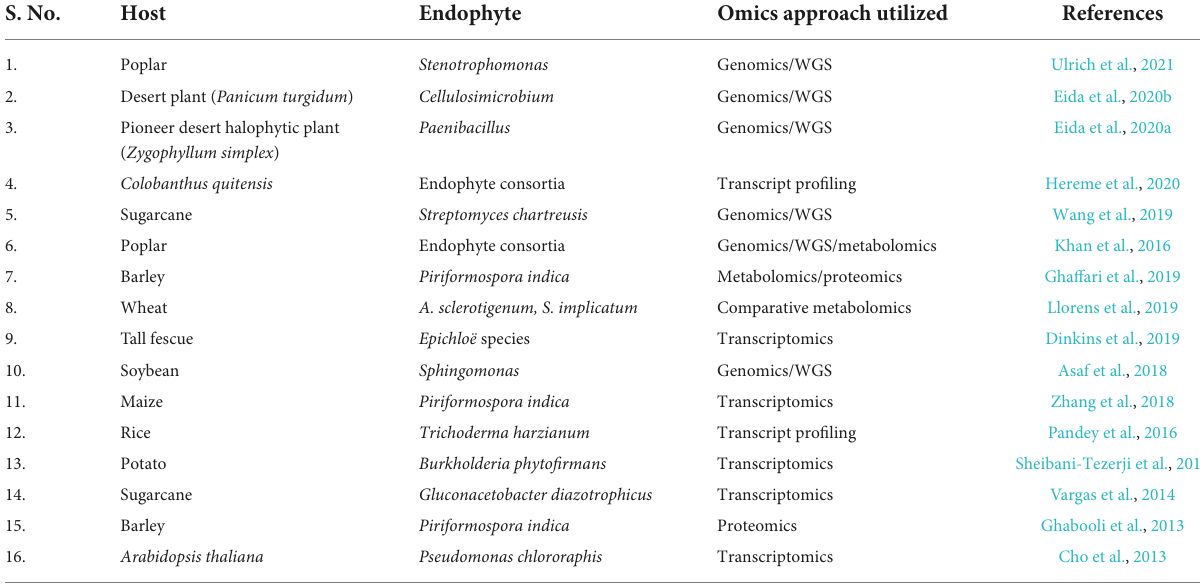
TABLE 3 Omics-based studies on plant-endophyte relationship to study the endophyte mediated drought stress tolerance conferred to host plant. S.